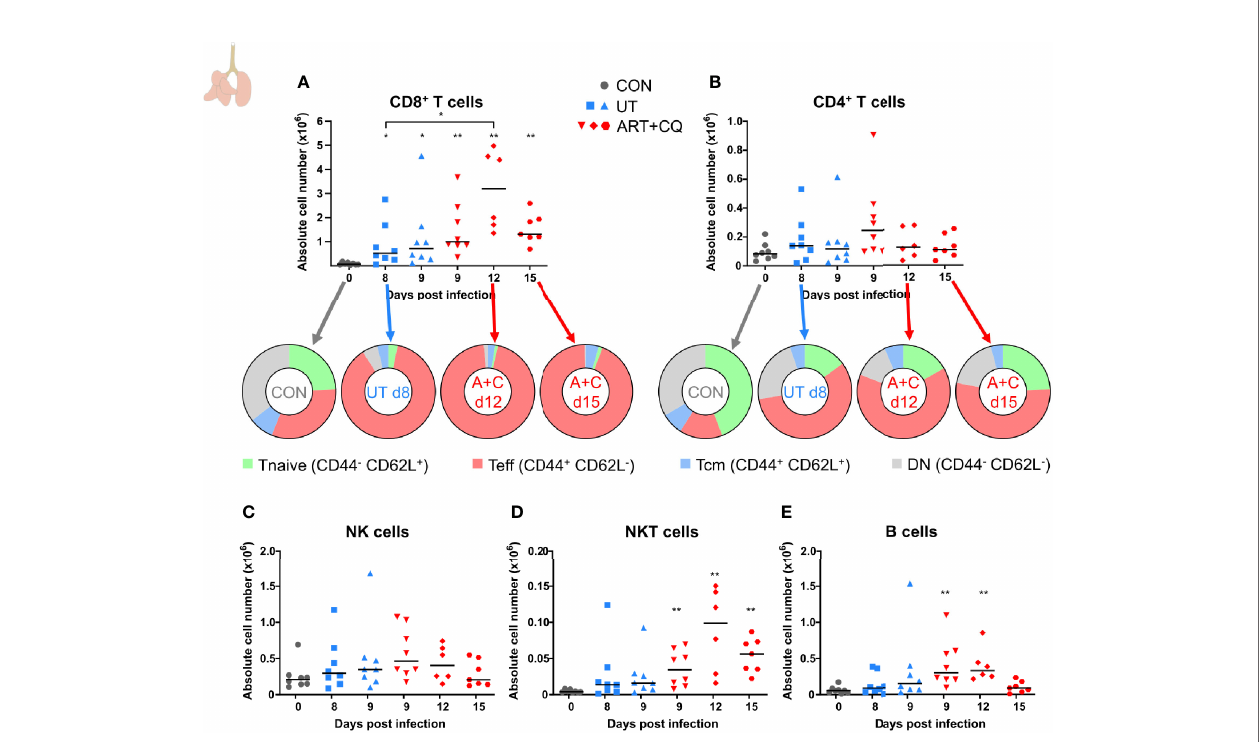
FIGURE 2 | Dynamics of the lymphocyte populations in the lungs during resolution of malaria-associated acute respiratory distress syndrome (MA-ARDS). C57BL/6 mice were infected with Pb NK65. Mice were injected daily from 8 until 12 days p.i. with 10 mg/kg ART + 30 mg/kg CQ. Mice were dissected at the indicated days p.i. Leukocytes were isolated from the lungs according to protocol 1 and fl ow cytometry was performed. (A, B) The absolute numbers of CD8 + T cells (CD45 + CD3 + NK1.1 − CD8 + ) and CD4 + T cells (CD45 + CD3 + NK1.1 − CD4 + ) and the proportions of Tnaive (CD44 − CD62L + ), Teff (CD44 + CD62L − ), and Tcm (CD44 + CD62L + ) of the total cell population are shown. Percentages of these subsets are shown in Supplementary Figure 3 . (C – E) The absolute numbers of NK cells (CD45 + CD3 − NK1.1 + ), NKT cells (CD45 + CD3 + NK1.1 + ), and B cells (CD45 + CD3 − NK1.1 − B220 + ) were calculated. Compilation of two experiments. Each symbol represents data of an individual mouse. n=8 for CON on day 0, UT at 8 and 9 days p.i and ART+CQ at 9 days p.i., n=6 for ART+CQ at 12 days p.i., n=7 for ART+CQ at 15 days